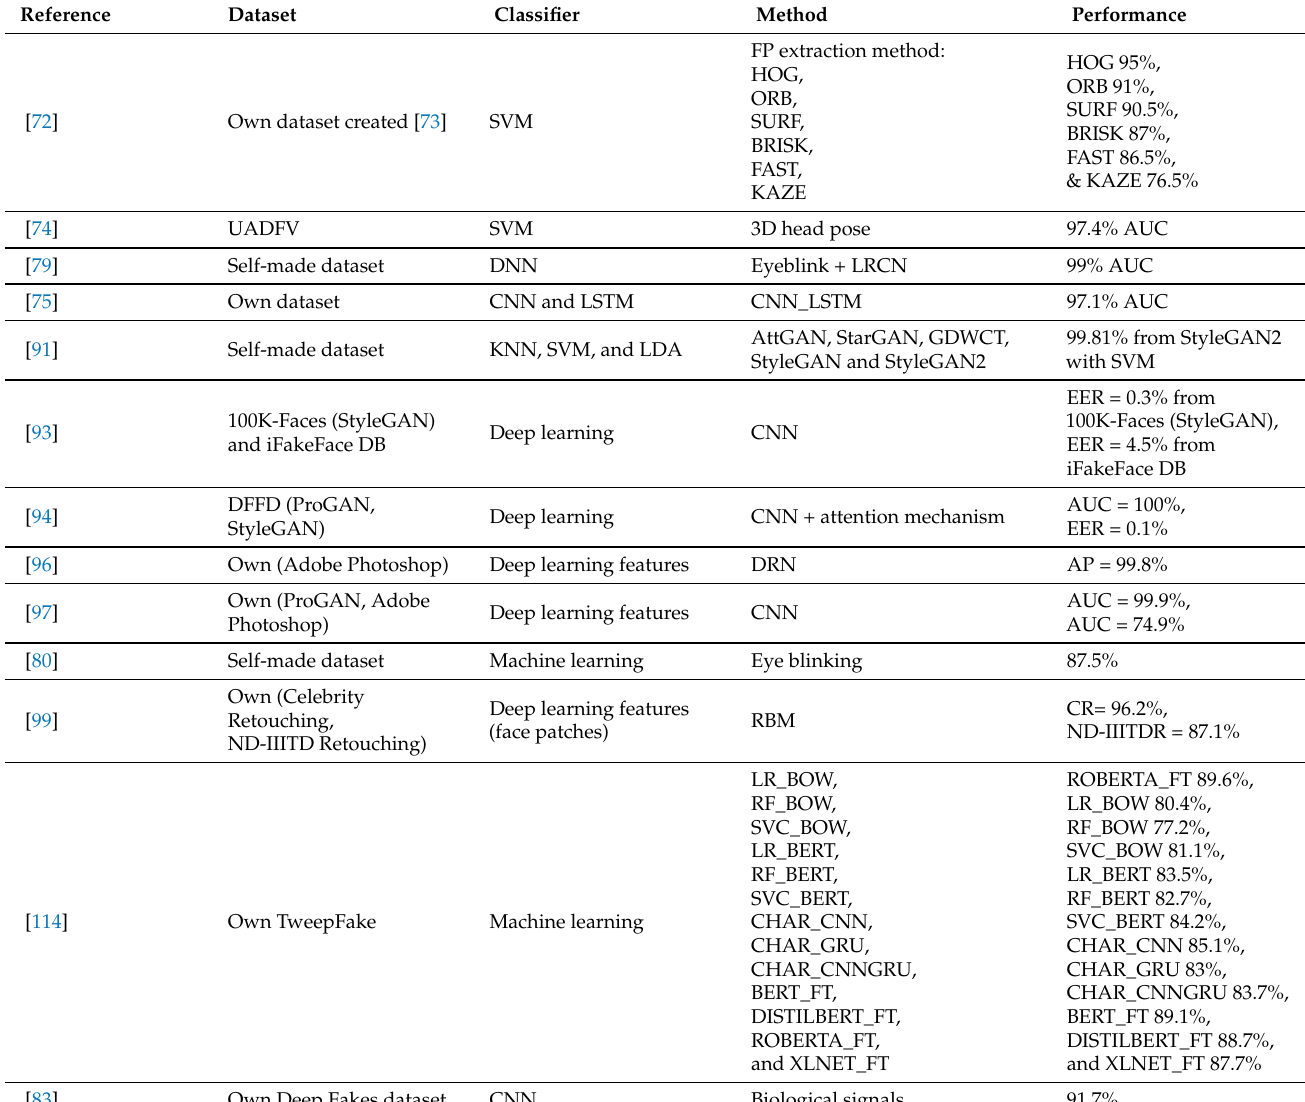
Table 4. Comparison table of self-made